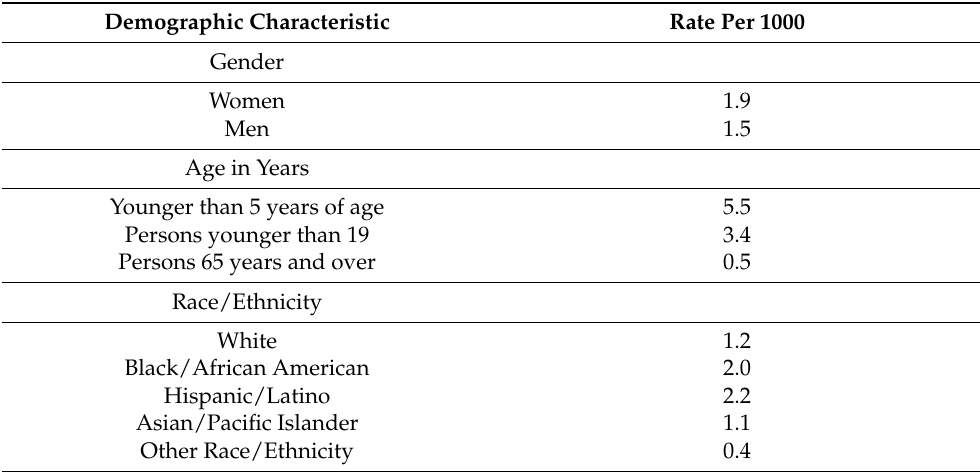
Table 3. Rate of acute urticaria-related emergency department visits by demographic characteristic, San Joaquin Valley, 2016–2017.